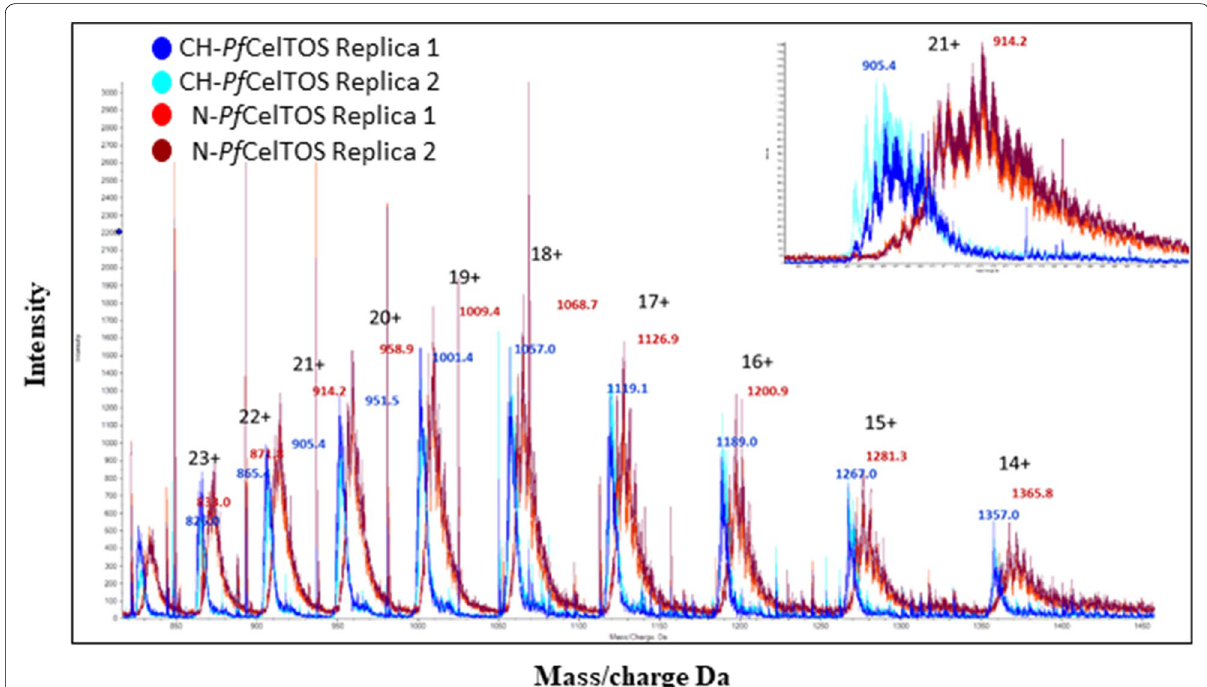
Fig. 3 Electrospray mass spectrometry. Mass spectra of N- Pf CelTOS (red) and CH- Pf CelTOS (blue) overlaid with respective replicates (burgundy and cyan) (inset: zoomed in on 21 charged ions) +